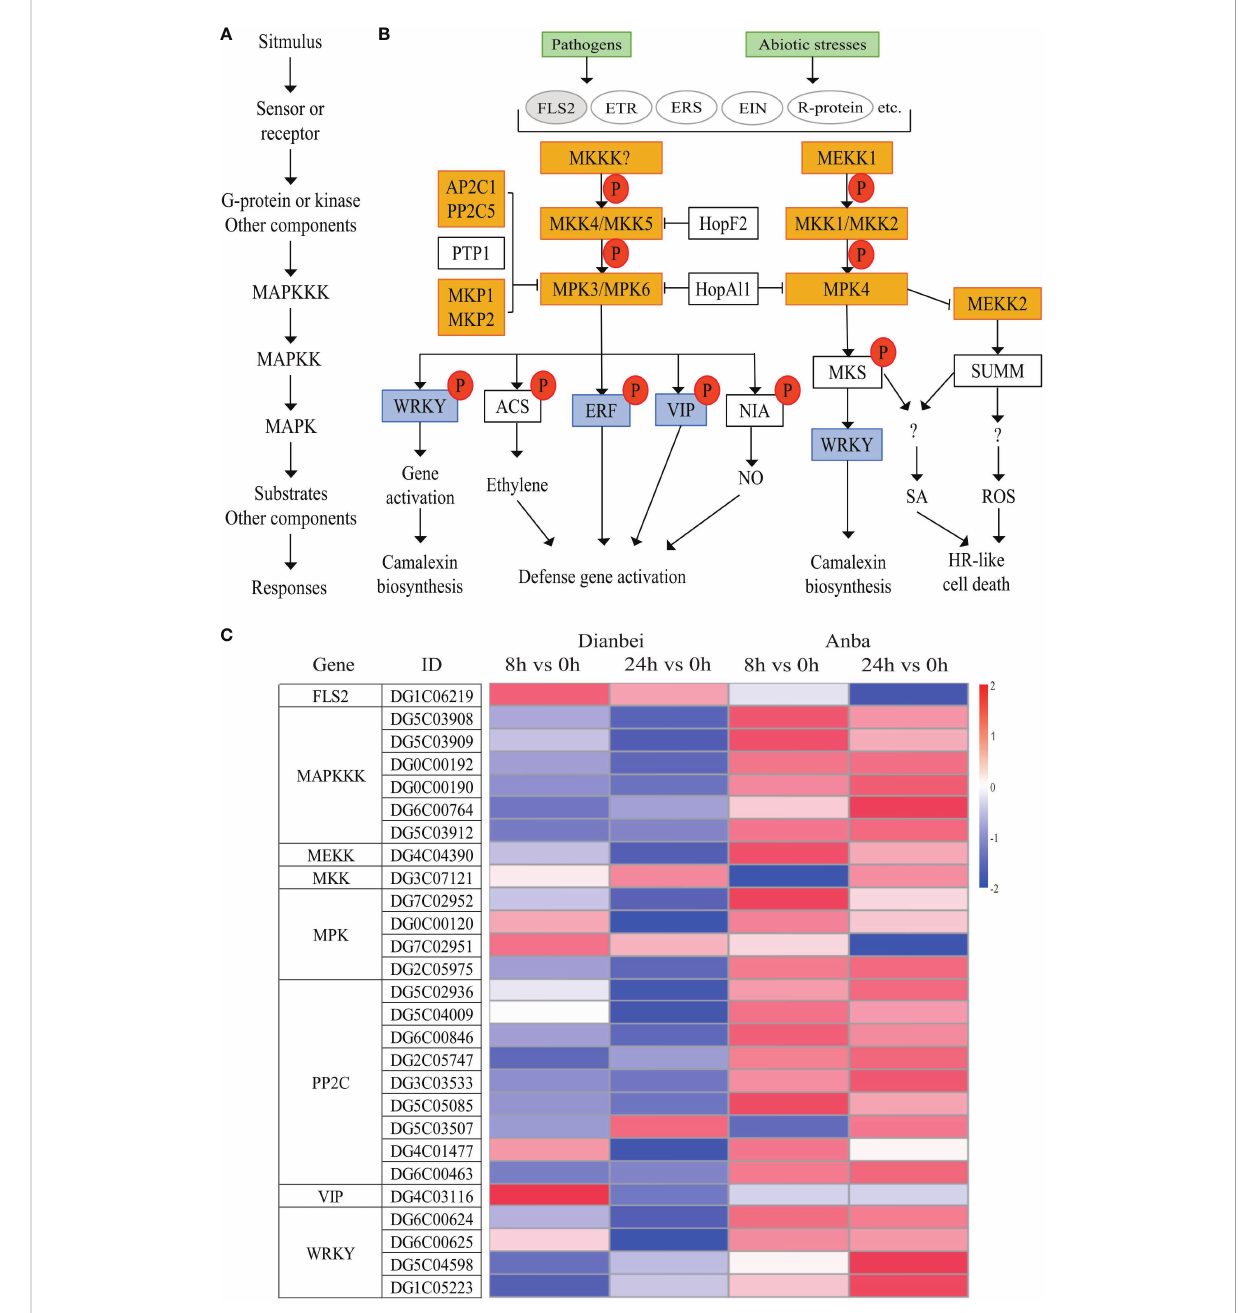
FIGURE 7 MAPK signal transduction pathway. (A) Plant MAPK cascades pattern. (B) Possible functions of various MAPK cascades in plants. (C) Heatmap of DEGs involved in the MAPK signaling pathway. The y-axis shows the cluster dendrogram of DEGs, and the x-axis shows the sample